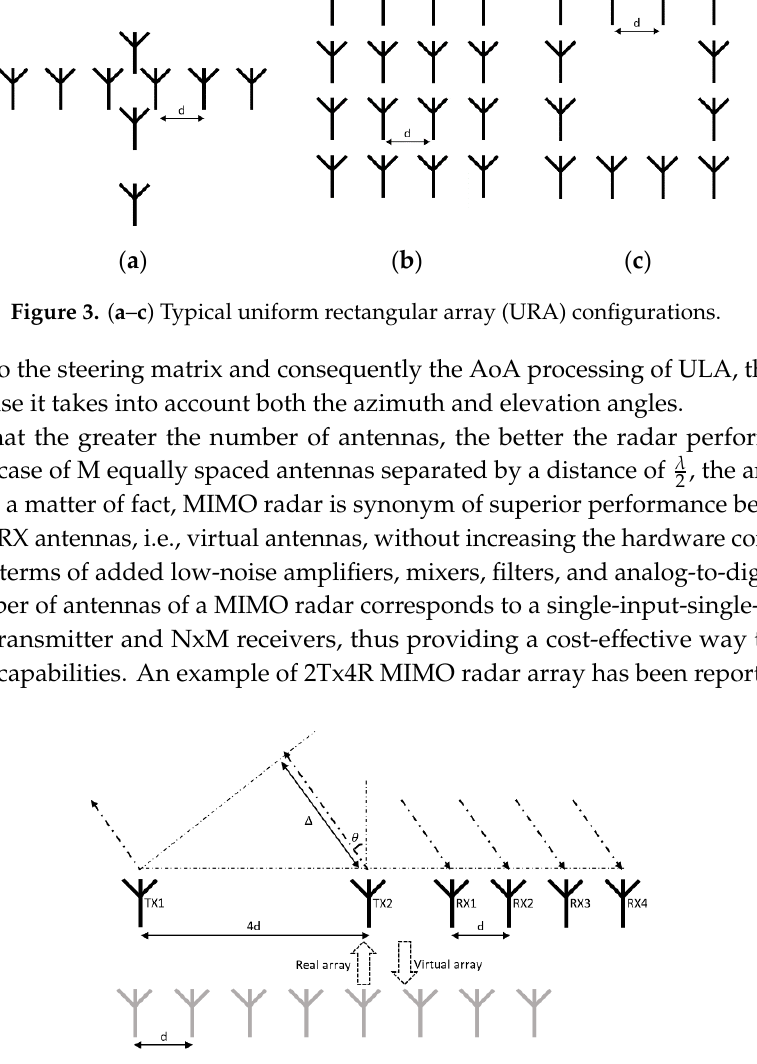
Figure 4. 2Tx4R multiple-input-multiple-output (MIMO) radar array.